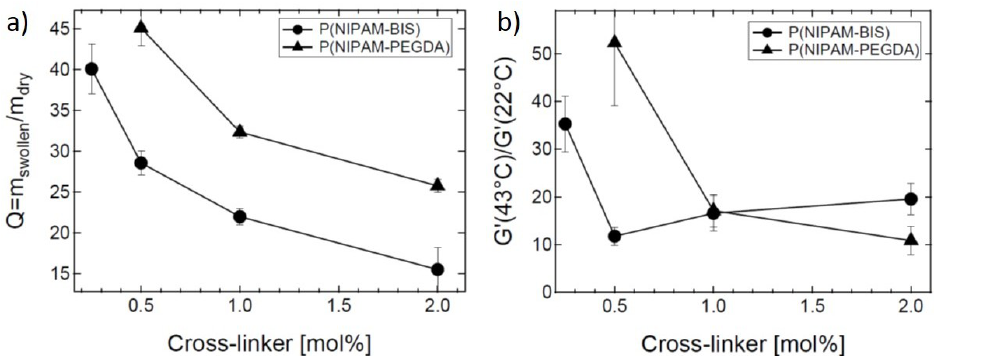
Figure 13. Comparison of PNIPAM microgels cross-linked with BIS (circles) or PEGDA (triangles) with respect to their ( a ) swelling behaviour and ( b ) ratio of the storage moduli G (cid:48) at 43 ◦ C and 22 ◦ C. Data taken from [66].